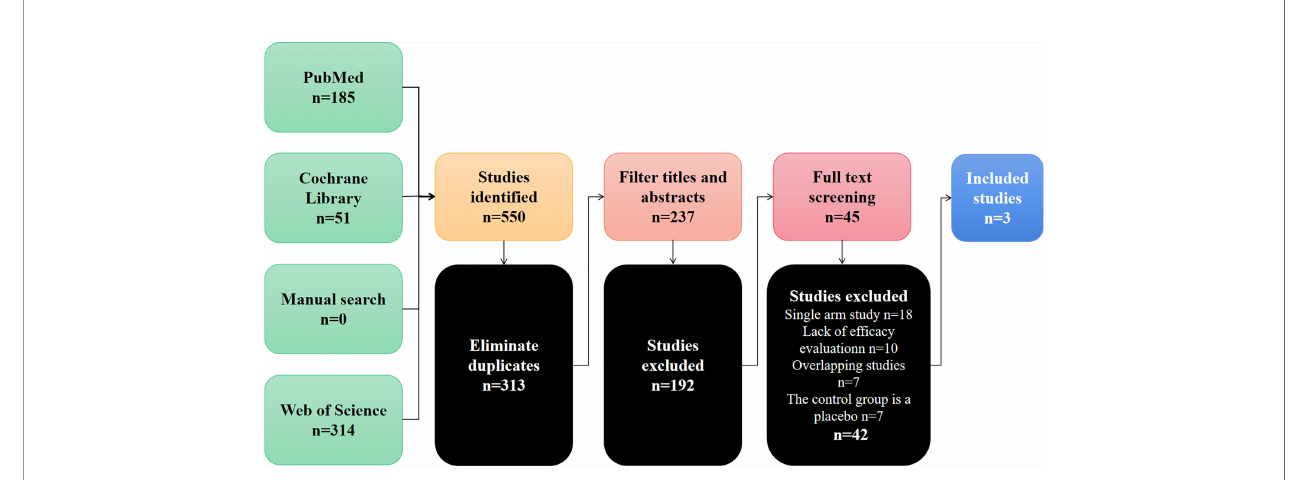
FIGURE 1 | Flow graph of selection of included